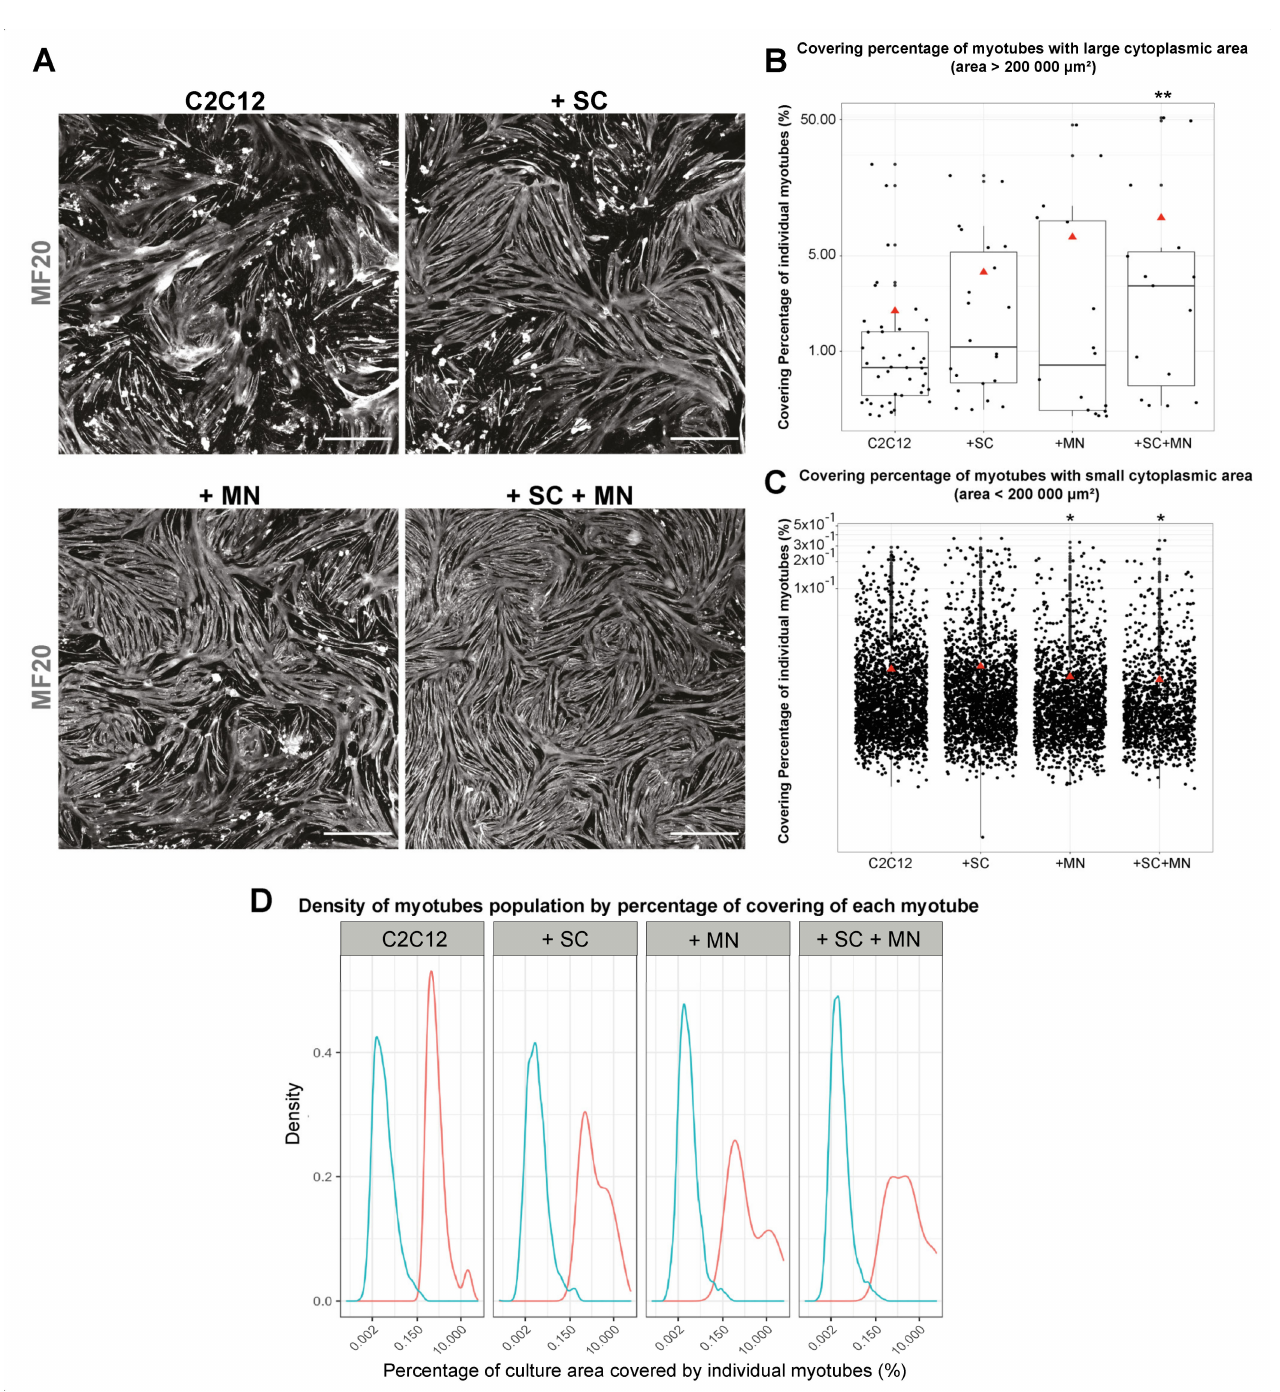
Figure 6. Cocultures promote formation of myotubes with increased cytoplasmic area. C2C12 cells were cultured on cover slips for three days in the absence (C2C12) or presence of either SC (+ SC), MN (+ MN), or both (+ SC + MN). Then, cells were fixed and immunostained for the muscle cell marker myosin heavy chain (MF20). ( A ) Representative microscopic overviews of MF20 fluorescence signals under culture conditions as indicated. Scale bars: 1000 µ m. ( B , C ) Quantification of covering area of myotubes classified into two populations: large-type myotubes (>200,000 µ m 2 ) ( B ) and small-type myotubes (<200,000 µ m 2 ) ( C ). Red triangles on boxplots indicate mean values for given conditions; y-axes logarithmic. * p < 0.05, ** p < 0.01. ( D ) Density curves of analyzed myotubes expressed according to their respective percentages of covering area of the total cellular culture area. Blue and pink lines: density curves for myotubes with low and high cytoplasmic area, respectively; x-axes